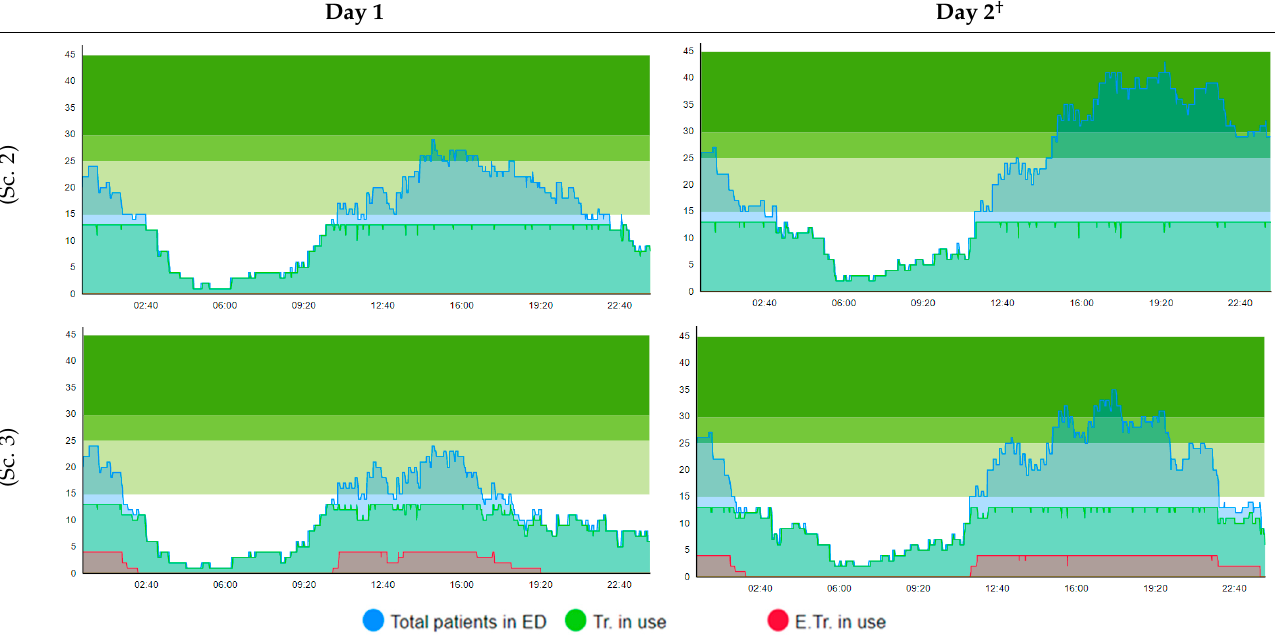
Table 10. Simulation output crowding graphs for comparing Sc.3 with